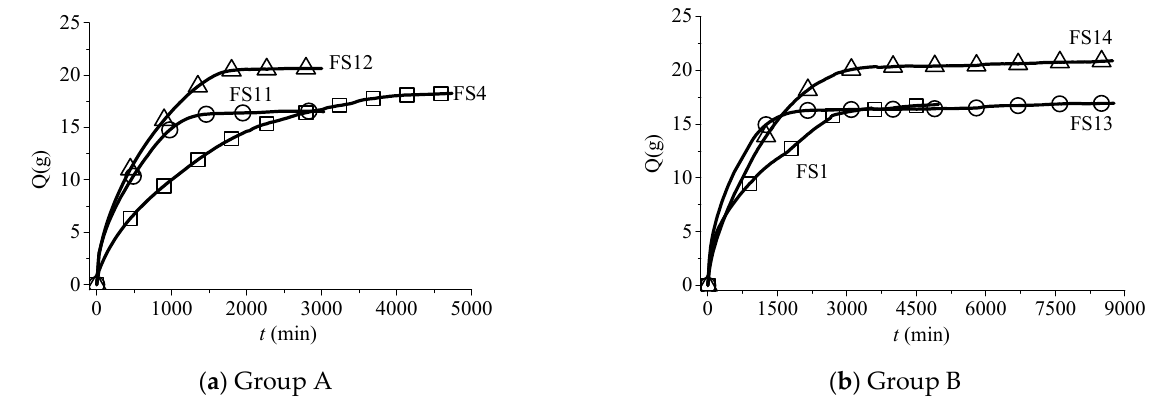
Figure 8. Relationship between water imbibition content and time. Table 4. Fitting results of parameters during imbibition test ( R 2 is the correlation coefficient). Sample.